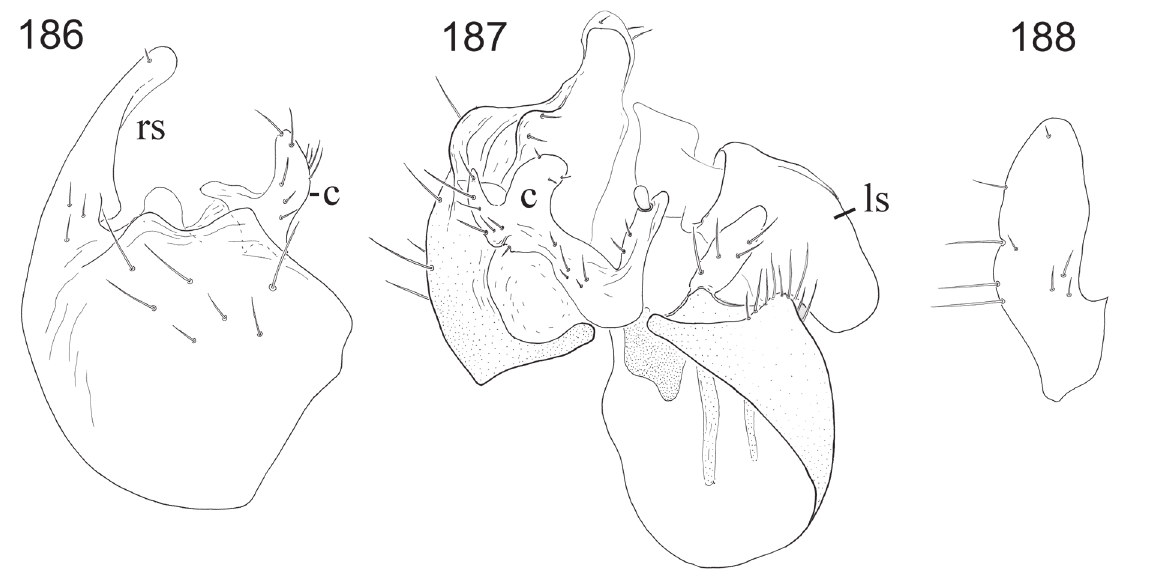
Figs 186-188. Nanodromia narmkroi Grootaert & Shamshev, 2003, ♂ terminalia. 186 . right epandrial lamella, lateral view. 187 . epandrium with cerci, dorsal view. 188 . left surstylus, lateral view. (after Grootaert & Shamshev